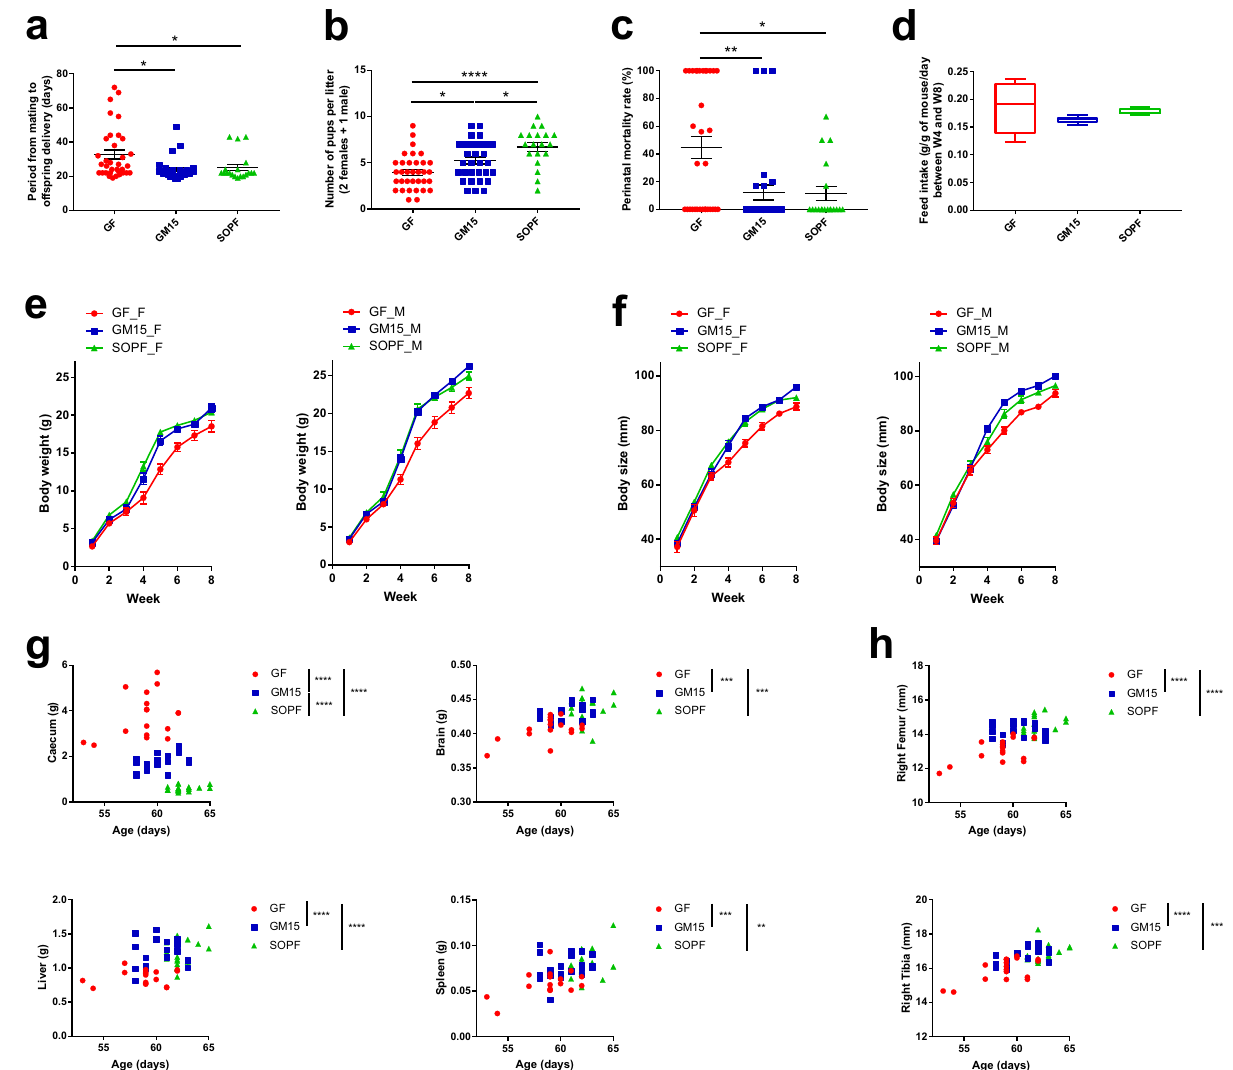
Fig. 3 Macroscopic phenotyping of mice from two consecutive fi lial generations (F1 – F2). a – c One-way ANOVA analyses of the reproductive performance, where dots, lines, and error bars represent, respectively, individual litters (34 GF, 31 GM15, and 19 SOPF), means, and SEM. a Pups delivery. Data are represented as days after mating. Dunn ’ s multiple comparison analyses. b Number of pups per litter. Data are represented as an individual number. Tukey ’ s multiple comparison analysis. c Perinatal mortality. Data are represented as percentages of mortality. Dunn ’ s multiple comparison analyses. d Feed intake normalized per gram of mouse per day over 4 weeks (17 GF, 21 GM15, and 20 SOPF mice housed in 6, 5, and 4 cages, respectively). Box plots extend from the 25th to 75th percentiles and show the center line as the median. Whiskers represent min and max data. e , f Body growth of mice bred with their mothers until week 4, where lines and error bars represent, respectively, means and SEM. Female (F) and male (M), respectively. Body weight and size curves. GF mice (7 F, 10 M), GM15 mice (9 F, 12 M), and SOPF mice (10 F, 10 M). g , h Organs weight or size impacted by age, fi lial generation, or sex were analyzed by the F test for multiple linear regressions, otherwise by one-way ANOVA. Each animal is represented by a dot at the age of the sacri fi ce (17 GF, 21 GM15, and 20 SOPF). * P < 0.05, ** P < 0.01, *** P < 0.001, and **** P < 0.0001. Source data are provided as a Source Data fi